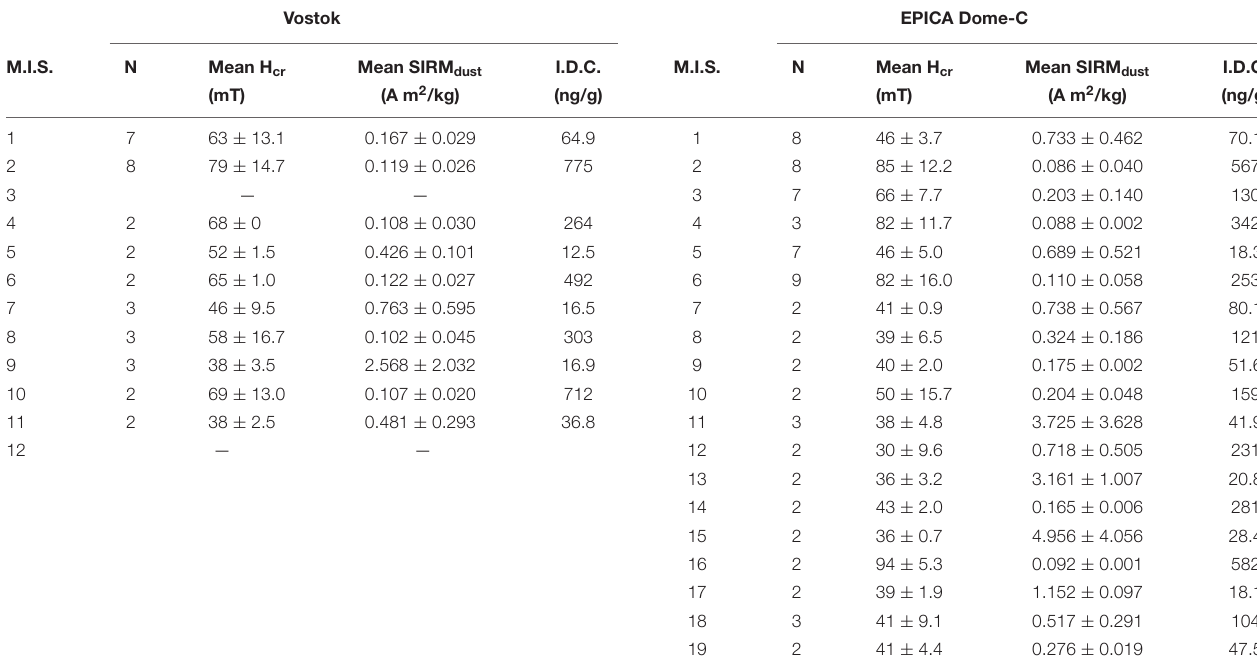
TABLE 1 | Summary of available magnetic data from Vostok and EPICA Dome-C, averaged over their climatic stages. Vostok EPICA Dome-C